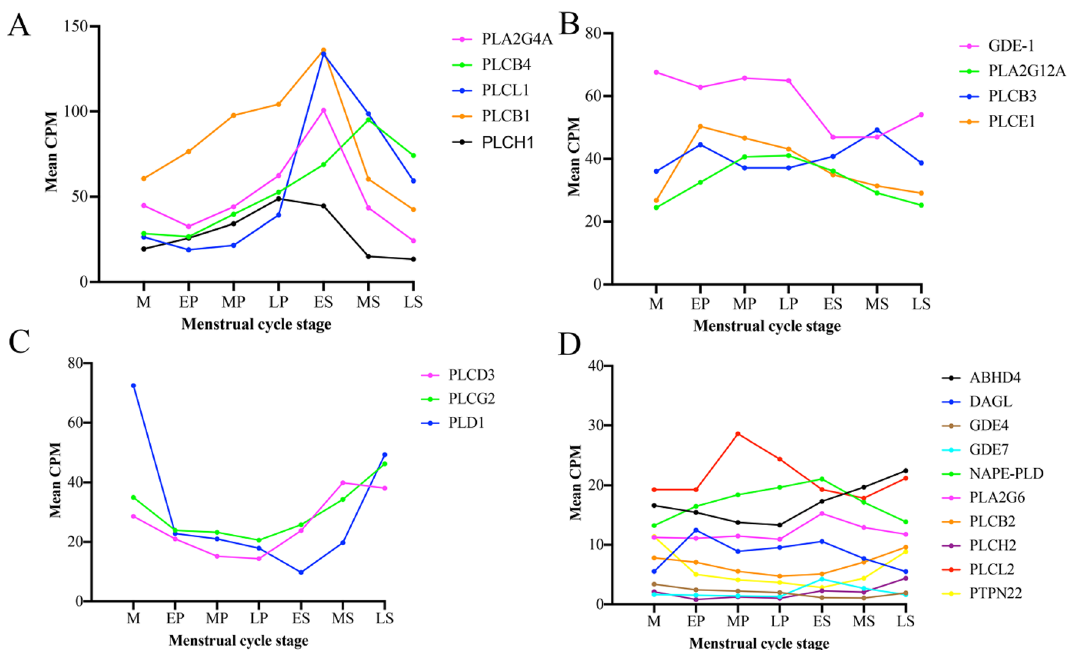
Figure 2. The expression profile of the four distinct groups of endocannabinoid synthesizing enzymes. ( A ) Group 1 showed high gene expression (≈ 50–150 CPM) that increased across the proliferative stage and peaked during the early secretory to mid secretory stage. ( B ) The second group was characterised by median gene expression (≈ 20–80 CPM) that generally increased from the menstrual to early proliferative stage and then showed a gradual decline. ( C ) This group was characterised by a low- medium expression (≈ 10–80 CPM) that decreased in the early proliferative stage and subsequently increased in the secretory stage. ( D ) The fourth group was characterised by low gene expression (≈ 1–30 CPM) that showed only small changes across the stages. M = Menstrual, EP = Early proliferative, MP = Mid proliferative, LP = Late proliferative, ES = Early secretory, MS = Mid secretory, LS = Late